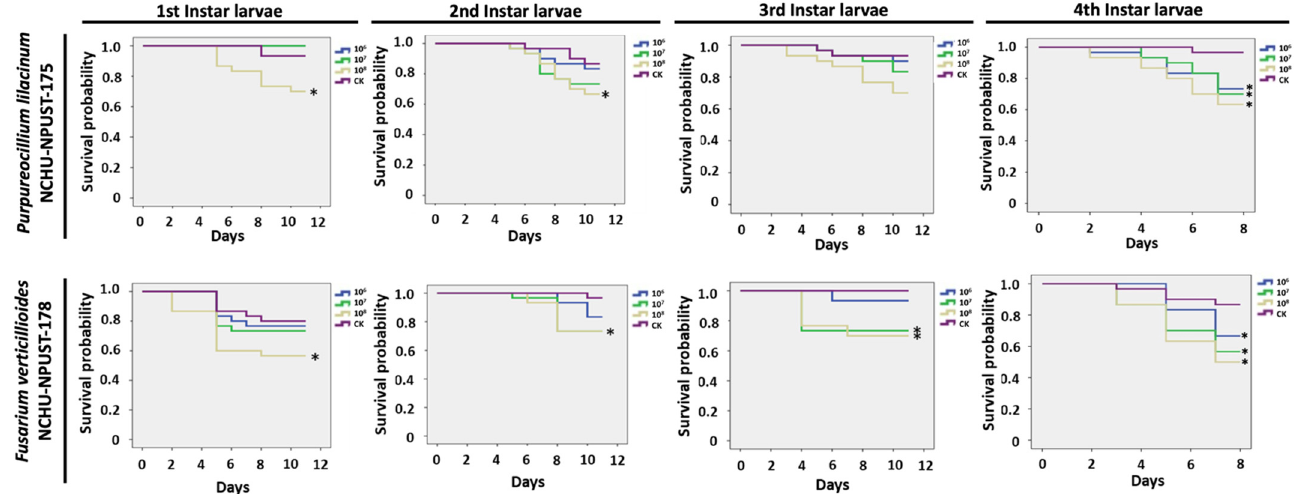
Figure 5. Survival probability of different instar larvae of F. taiwana after application of P. lilacinum PL-NCHU-NPUST-175 and F. verticillioides FV-NCHU-NPUST-178. The survival curves were analyzed based on Kaplan–Meier Method. * = significantly different ( p ≤ 0.05) based on log-rank test.